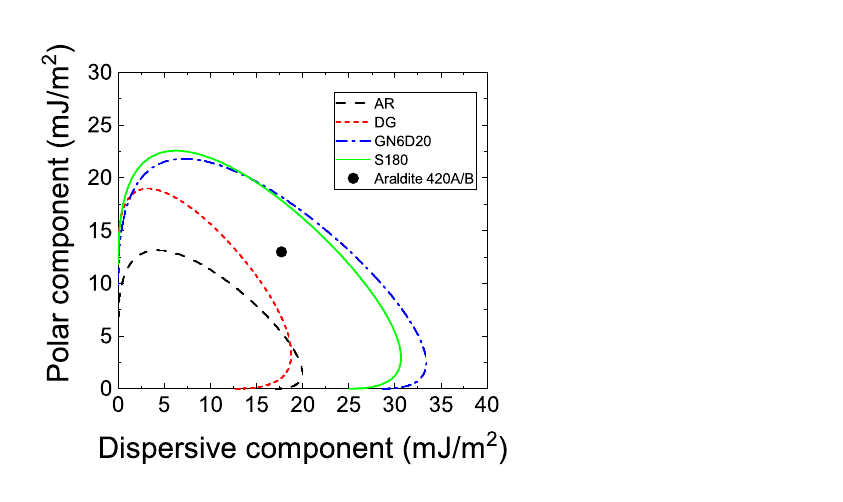
Figure 9. Surface wetting envelope diagrams of AR, DG, sanded (S180), and GN6D20 samples.